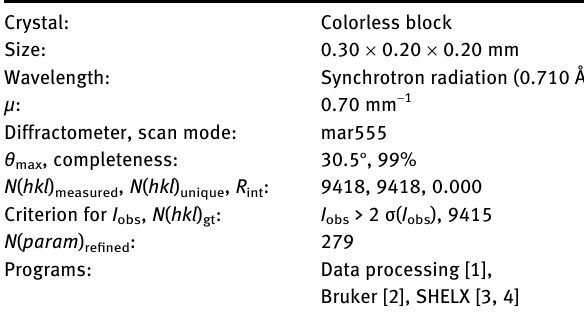
All reagents and solvents are analytically pure and used without further purification. The D-H